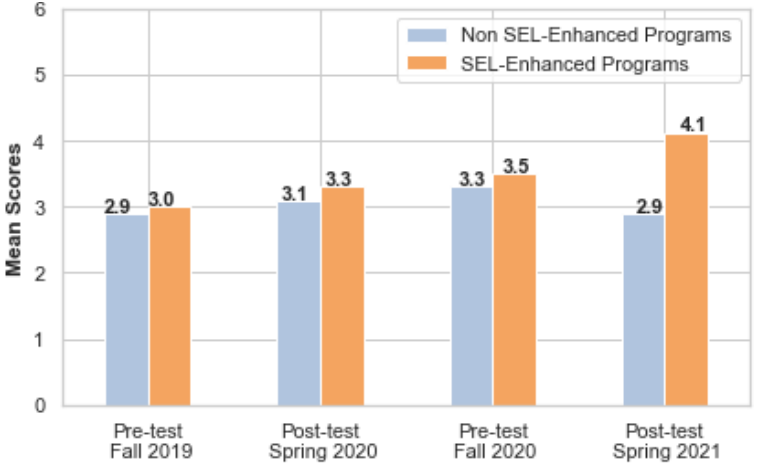
Figure 1. Mean Pretest and Posttest Youth SEL Scores at SEL-Enhanced and Non- SEL-Enhanced Programs in Years 1 and